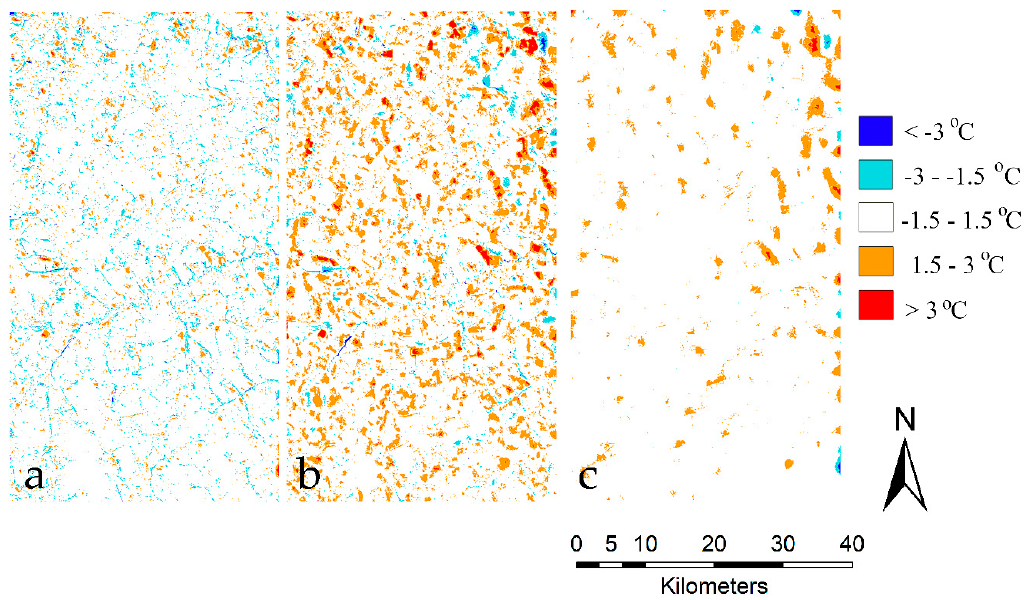
Figure 7. Residuals maps of ( a ) TsHARP Landsat at a 60-m spatial resolution. ( b ) TsHARP Sentinel at a 60-m spatial resolution, and ( c ) difference between TsHARP Landsat and TsHARP Sentinel for Site 1.